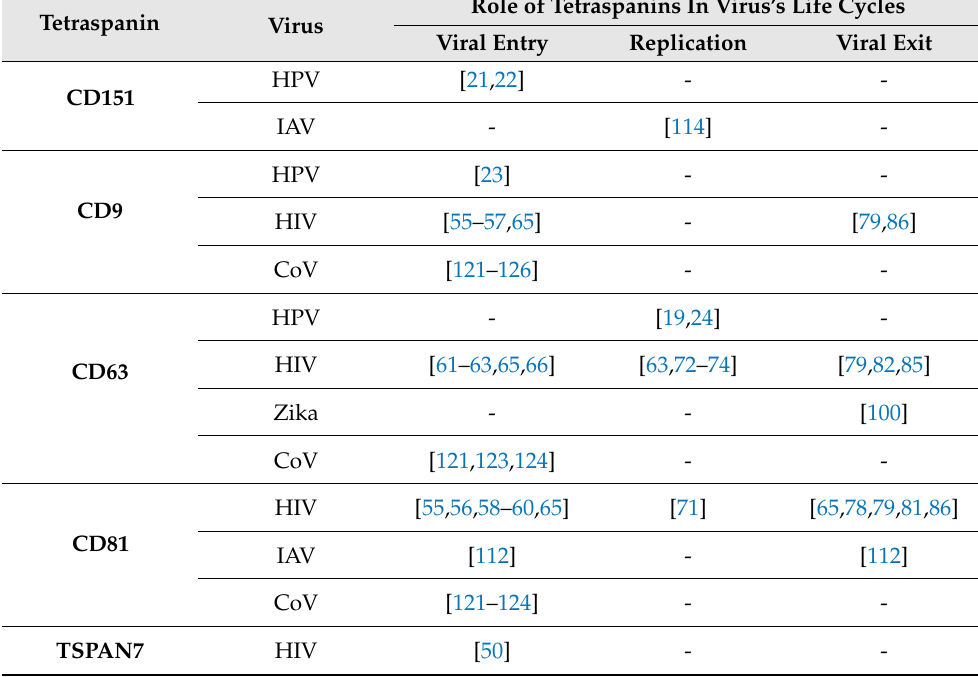
Table 1. Summary of tetraspanin functions in various virus life